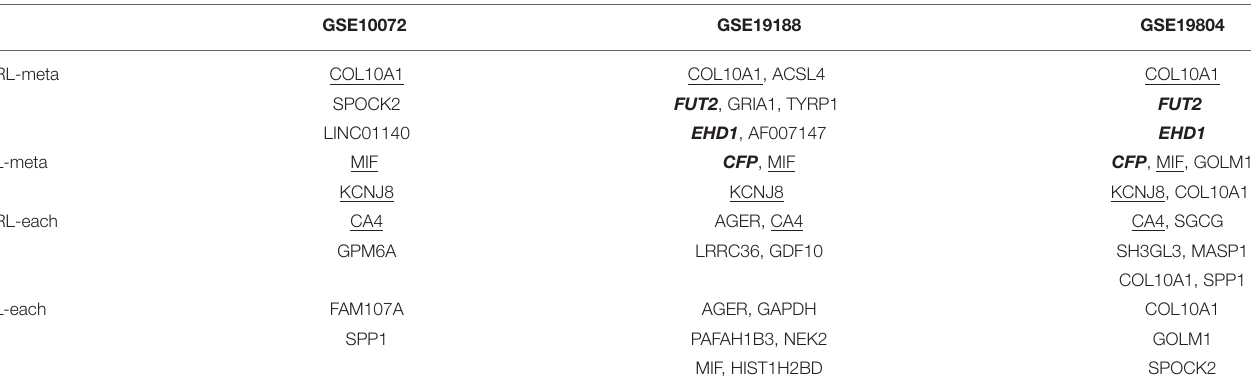
TABLE 6 | Gcta, L-meta, RL-each, and L-each in three lung cancer